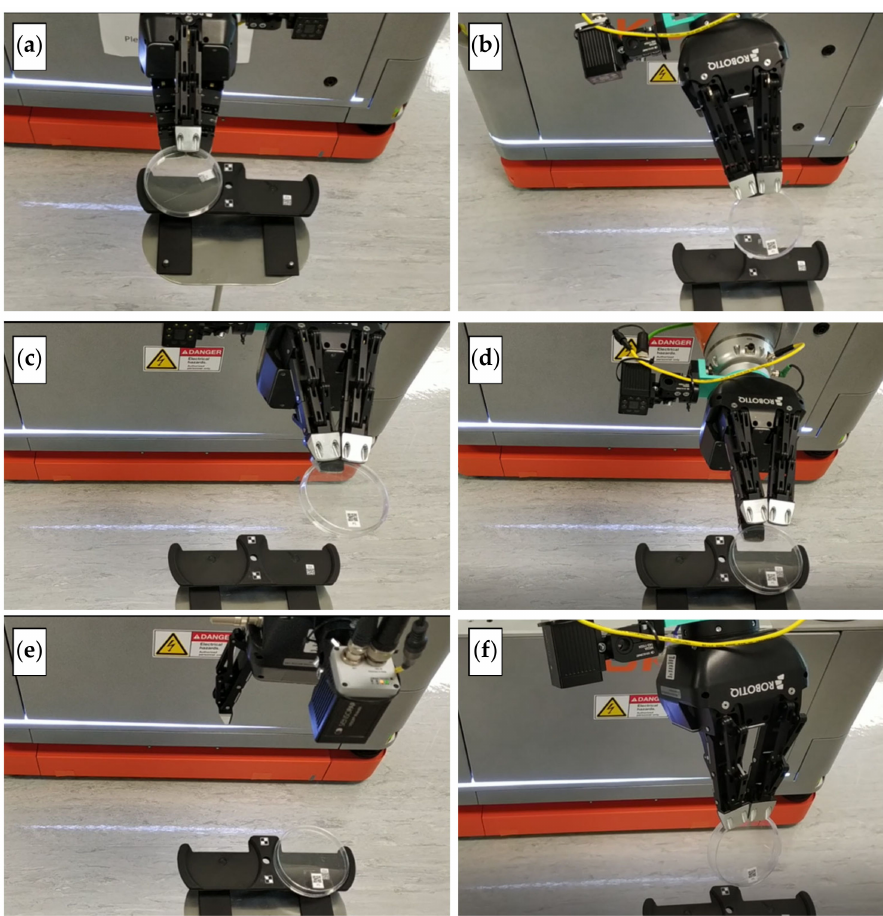
Figure 7. Scanning the barcode attached to Petri dish ( a ) picking the dish ( b ) Raising the dish ( c ) Flipping the dish ( d ) Placing the dish for scanning ( e ) Scanning the QR code ( f ) Collecting the dish